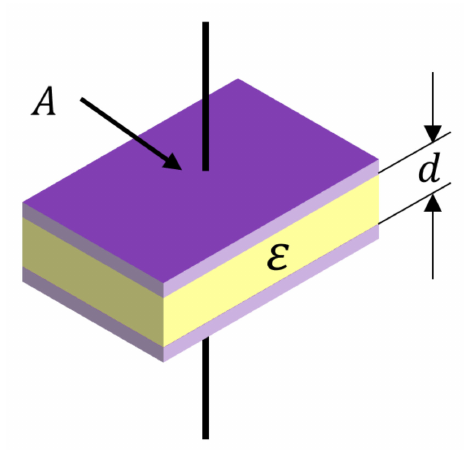
Figure 2. Dielectric material between two flat electrode plates. Capacitance ( C ) is proportional to the relative permittivity ( ε ) of the dielectric between the two flat electrode